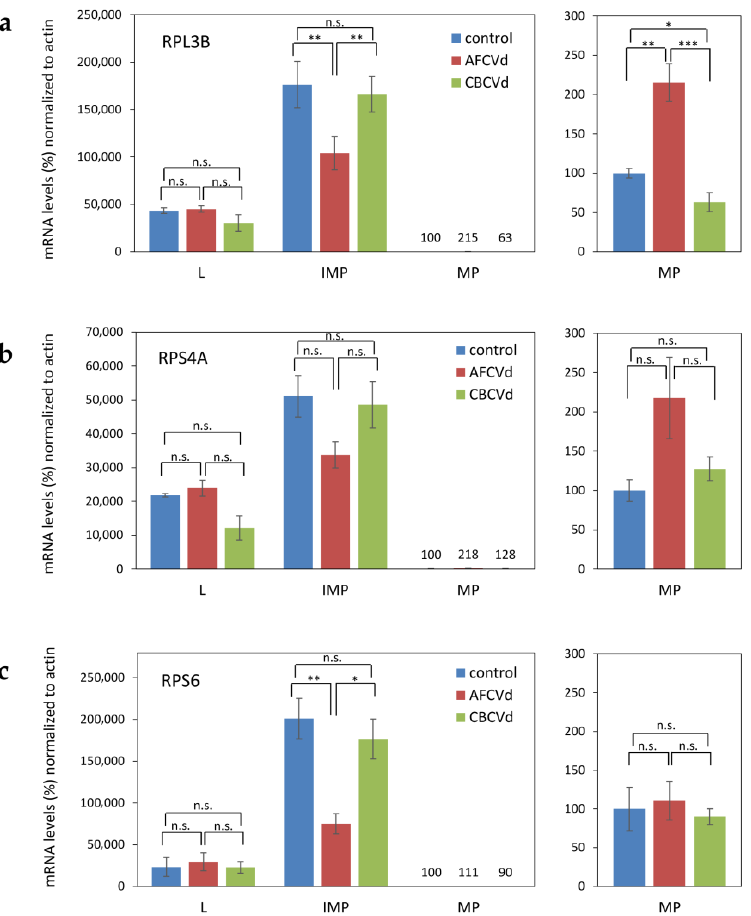
Figure 4. Relative levels of ribosomal protein mRNAs in healthy (control) and viroid infected (AFCVd and CBCVd) leaves (L), immature pollen (IMP) and mature pollen (MP) of N. benthamiana . In ( a – c ) individual ribosomal protein mRNAs are designated. To visualize the low levels of these mRNAs in MP, the respective parts are shown enlarged on the right side of each panel. Each column represents the mean ± S.D. of two replicates of each PCR reaction. Lines with asterisks (* p < 0.1; ** p < 0.05; *** p < 0.01) indicate statistically significant differences between connected values; (n.s.) statistically non-significant differences at p > 0.1.